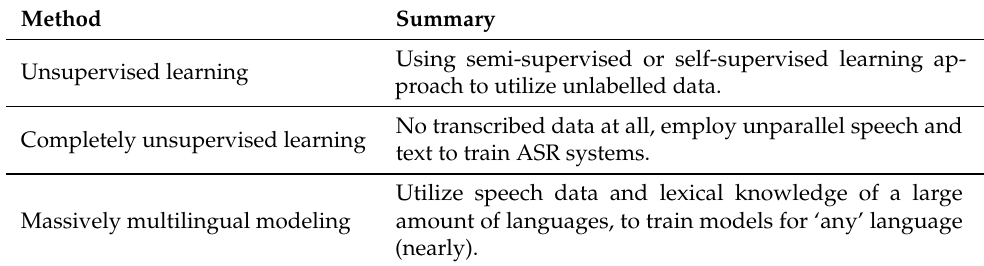
Table 1. Cont. Method